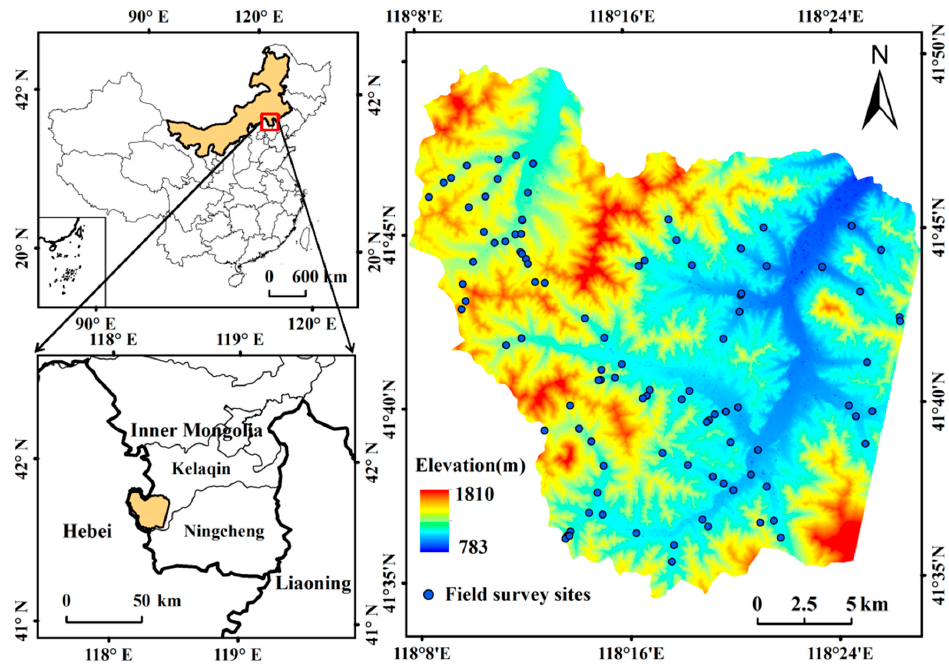
Figure 1. Study area: Wangyedian Forest Farm in eastern Inner Mongolia, China.